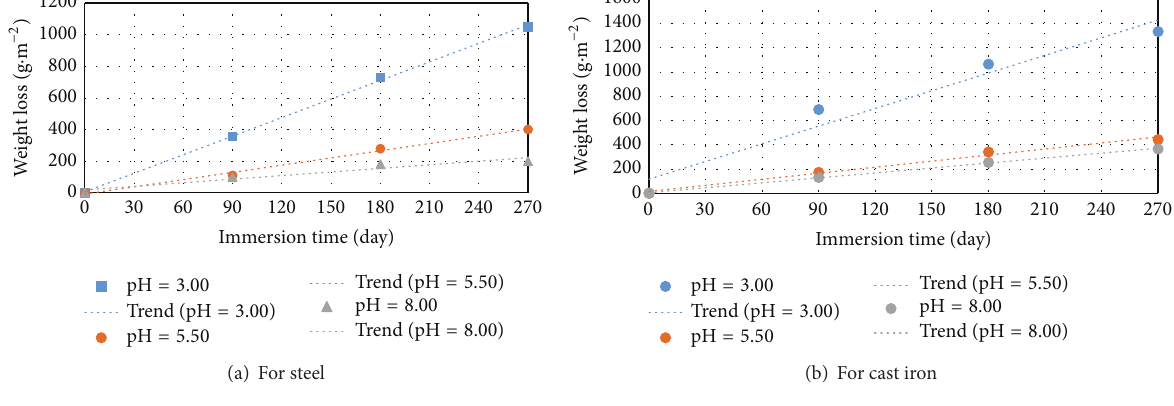
Figure 8: Weight loss of specimen.